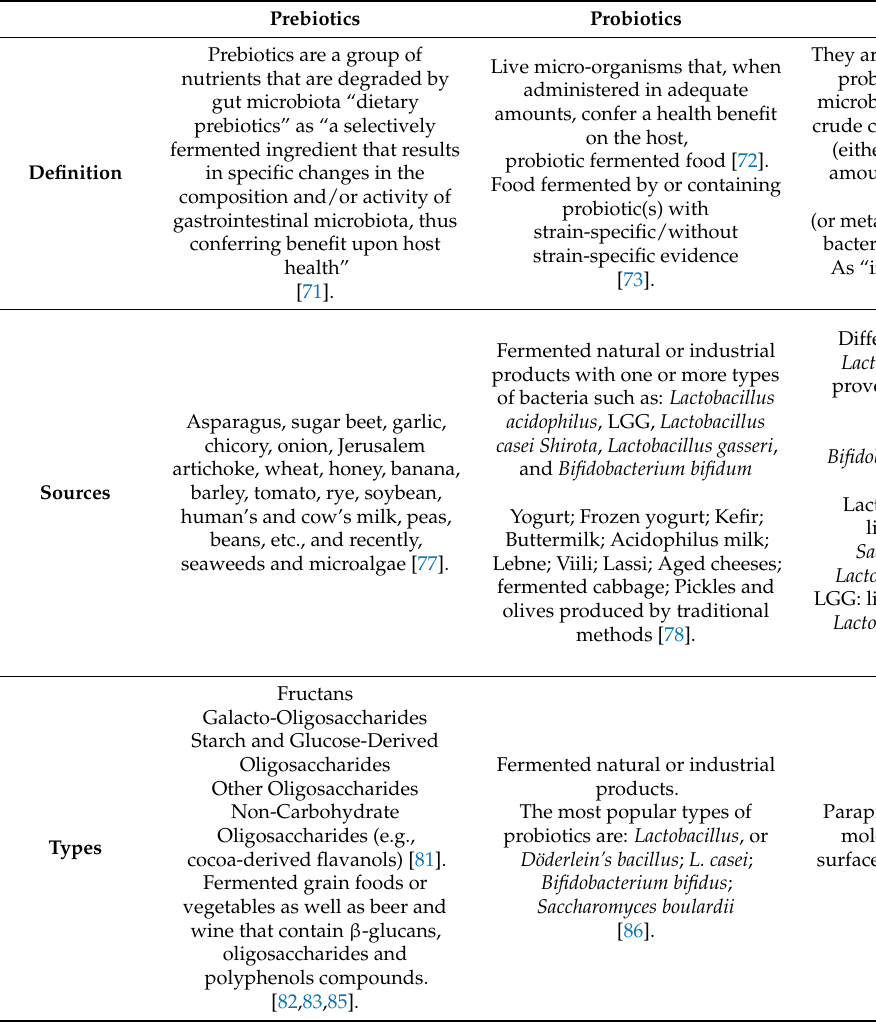
Table 1. Definitions, sources and types of pre-, pro-, para-, post-, and synbiotics